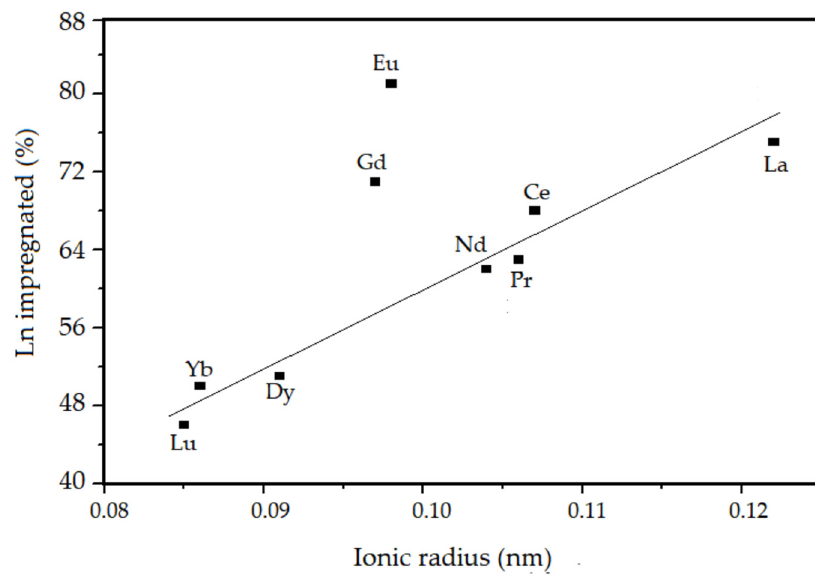
Figure 4. Lanthanide impregnated in the SiO 2 as a function of ionic ratio of de Ln.